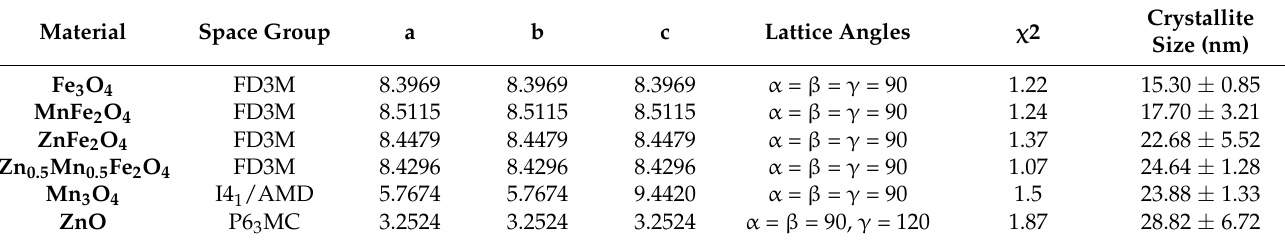
Table 2. Lattice parameters for various nanomaterials and calculated crystallite